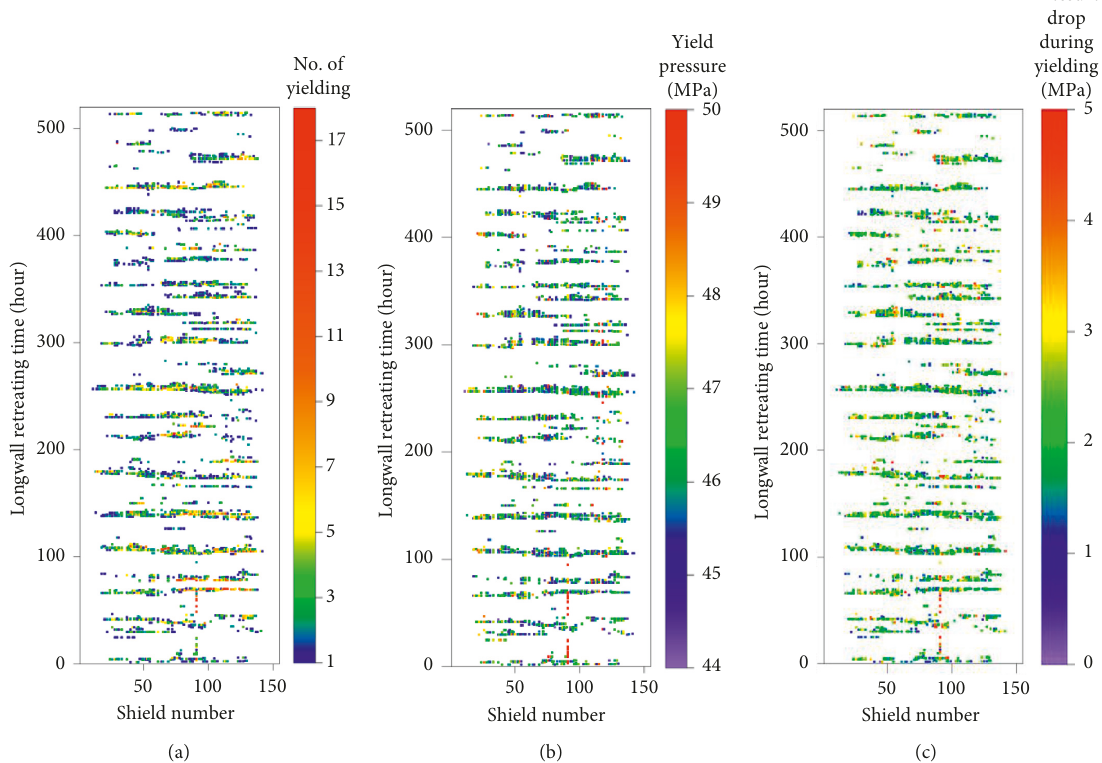
Figure 4: Evolution of (a) the number of yielding, (b) yield pressure, and (c) average pressure drop during a supporting cycle with longwall retreating time in panel LW22306 of Bulianta